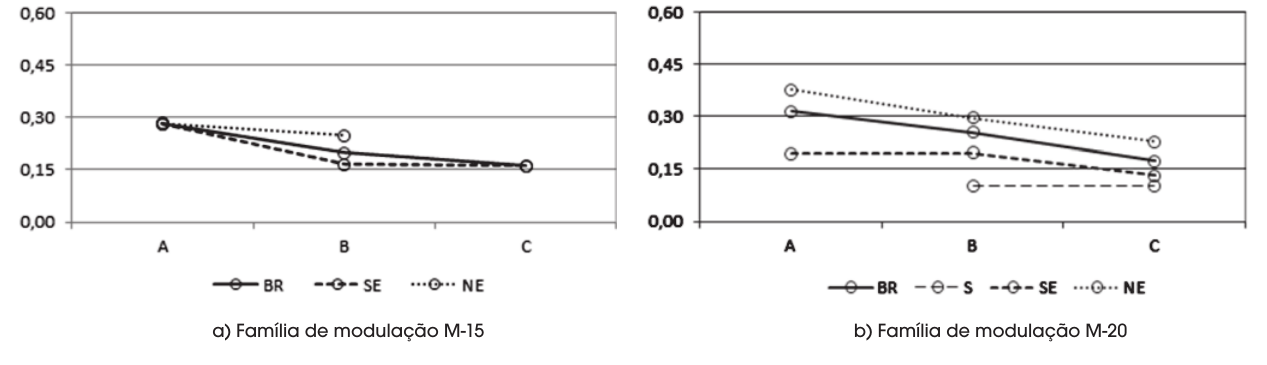
Figura 5 Coeficiente de variação (C.V.) da absorção em relação às famílias de